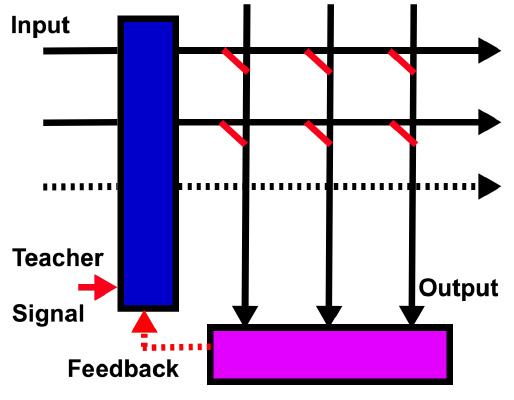
Figure 14. Feedback loop and learning in crossbar